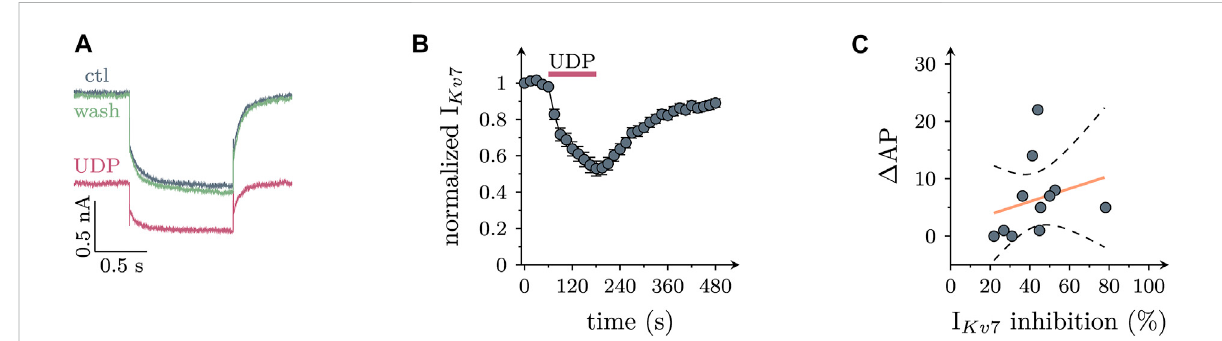
FIGURE 3 Effects of UDP on currents through K V 7 channels in sympathetic neurons. Cells were clamped to -30 mV and hyperpolarized to − 55 mV for 1 s periods once every 15 s. K V 7 currents were quanti fi ed by the amplitudes of slow current relaxations observed during the 1 s hyperpolarizations. (A) OriginalcurrenttracesobtainedfromaSCGneuronbefore(ctl),during,andafter(wash)thepresenceofUDP(10 µM). (B) Timecourseofnormalized amplitudes obtained before, during, and after the presence of 10 µM UDP as indicated ( n = 21) (C) Correlation between IK V 7 inhibition